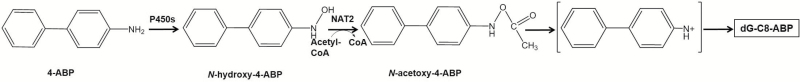
P450-mediated bioactivation pathway of 4-ABP.